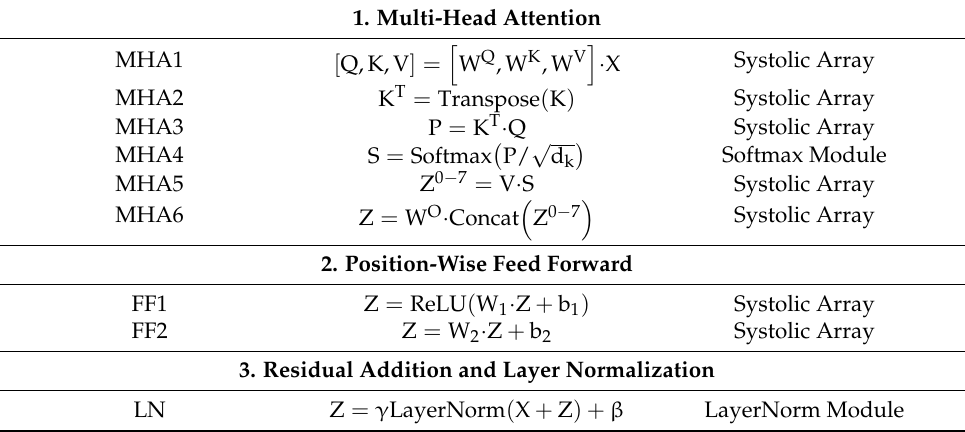
Table 1. The computation steps and module used for each step in the proposed